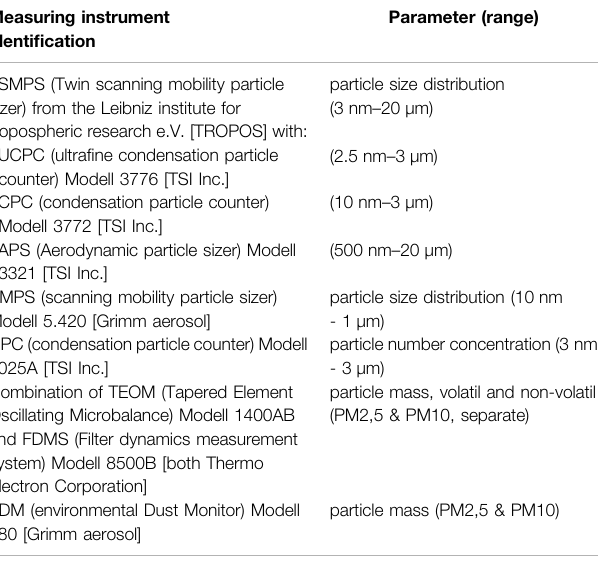
Parameter (range)